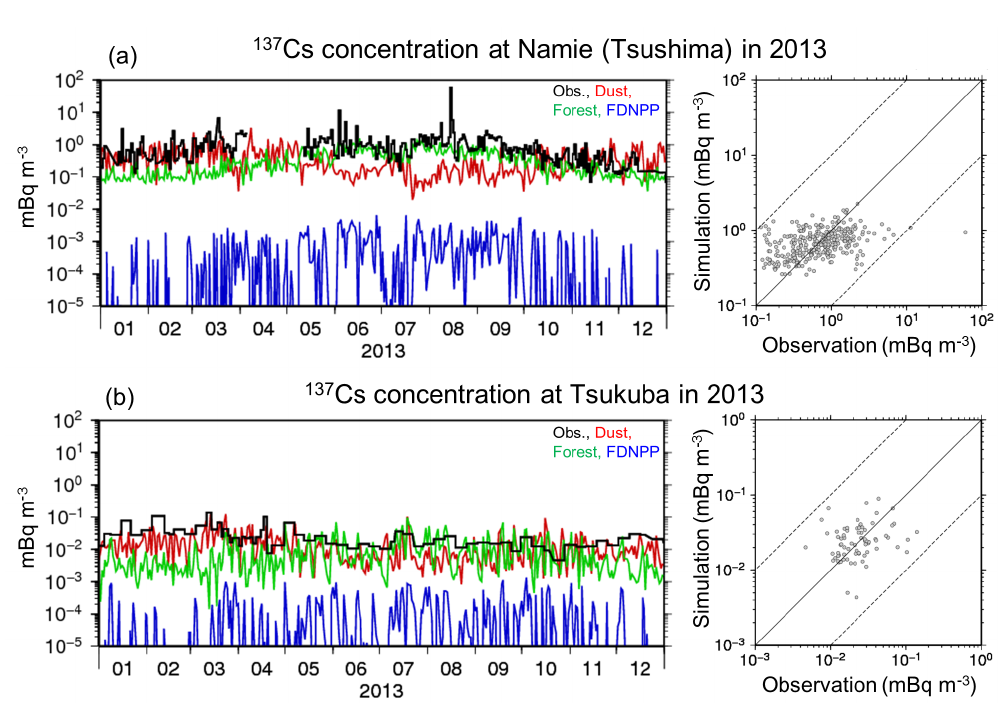
Figure 7. Time series of the surface air concentration of (black) observed 137 Cs and (colors) simulated daily 137 Cs levels on the left and scatterplots between observed and simulated total (i.e., sum of colors) 137 Cs at (a) Namie and (b) Tsukuba. The colored lines indicate simulated 137 Cs concentrations due to (red) re-suspension from soil using the scheme given in Ishizuka et al. (2016) (five times), (green) re-suspension from forest with a re-suspension rate of 10 − 7 h − 1 , and (blue) emission from the FDNPP reactor buildings with a constant emission rate of 10 6 Bqh − 1 . The deposition parameters of the simulation in the figure are E c = 0.04 and v d = 0.1cms − 1